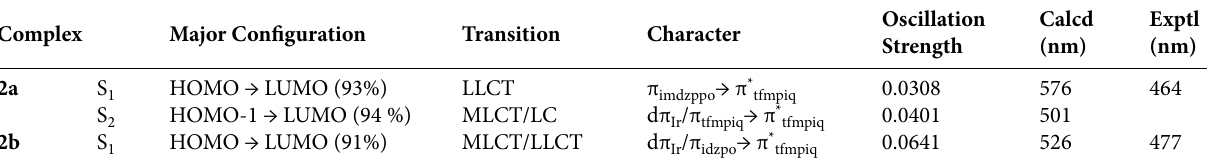
Table 5. Major configuration, transition characters, oscillator strength and calculated/experimental absorption wavelengths for 2a – 2b . Complex